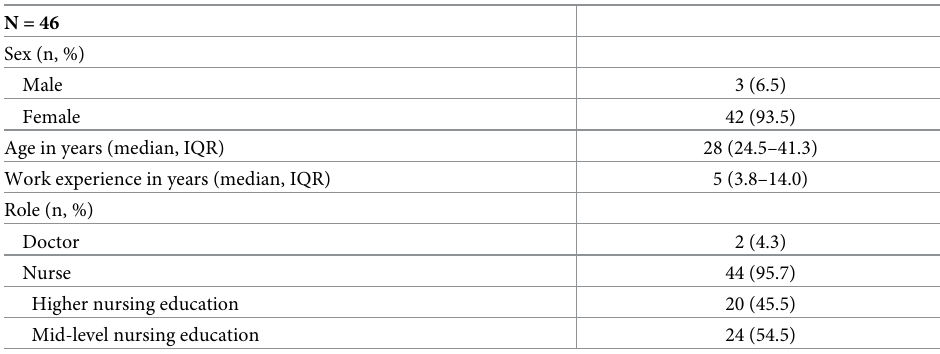
Table 2. Healthcare professionals’